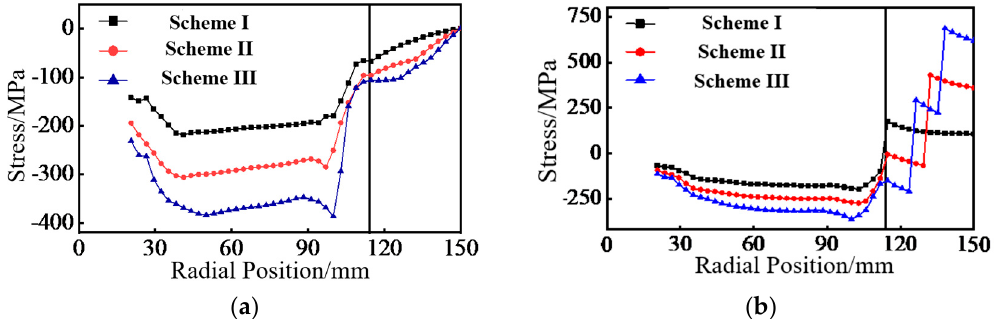
Figure 7. Stress curve of the flywheel at rest. ( a ) Radial stress curve; ( b ) Hoop stress curve. The stress distribution curve of the flywheel rotor under the maximum speed of each scheme is shown in Figure 8. Due to the centrifugal force, most of the radial compressive stress on the wheel hub is converted into tensile stress. The maximum tensile stress is inversely proportional to the number of the wheel flange layers, and the compressive stress on the wheel flange is also significantly reduced compared to when the flywheel is stationary. In scheme I, the radial stress at the junction of the wheel flange and the wheel hub is 3.77 Mpa, indicating that the interference assembly pressure between the wheel flange and the wheel hub has been completely released, and the flywheel rotor has failed. However, there is still radial compressive stress between the layers of the flywheel rotor in scheme II and scheme III, which can meet the use requirements. The changing trend of hoop stress is similar to that in the static state, but the stress value increases greatly.